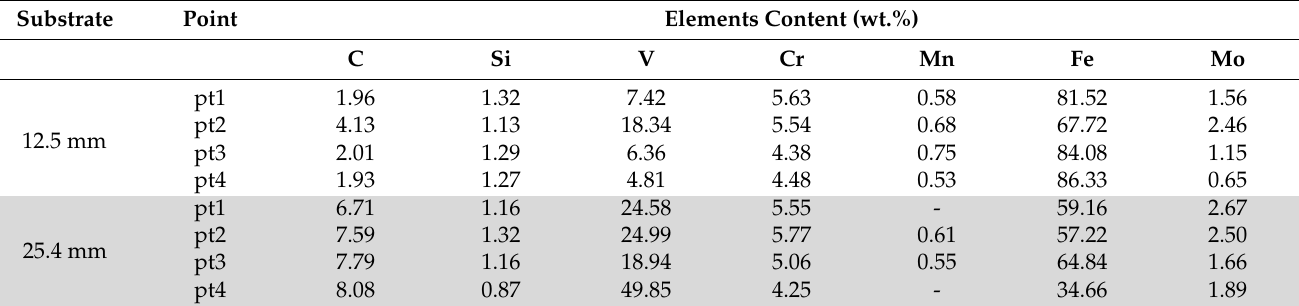
Figure 6. SEI SEM of Fe-Cr-C-V coating cross sections: ( a ) 12.5 mm thick substrate and ( b ) 25.4 mm thick substrate. Table 4. EDS results for the substrate thicknesses of 12.5 and 25.4 mm.